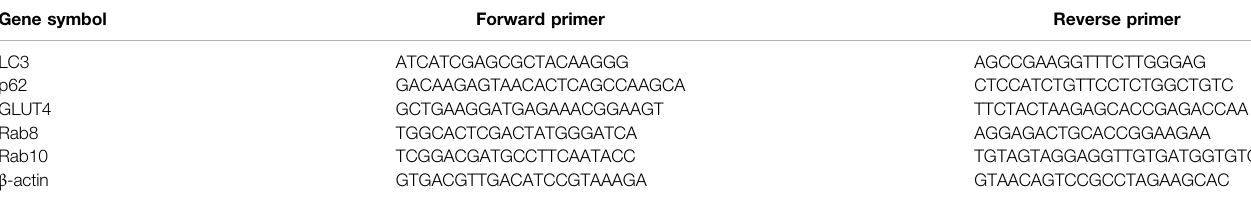
TABLE 1 | Primer sequences used in RT-qPCR